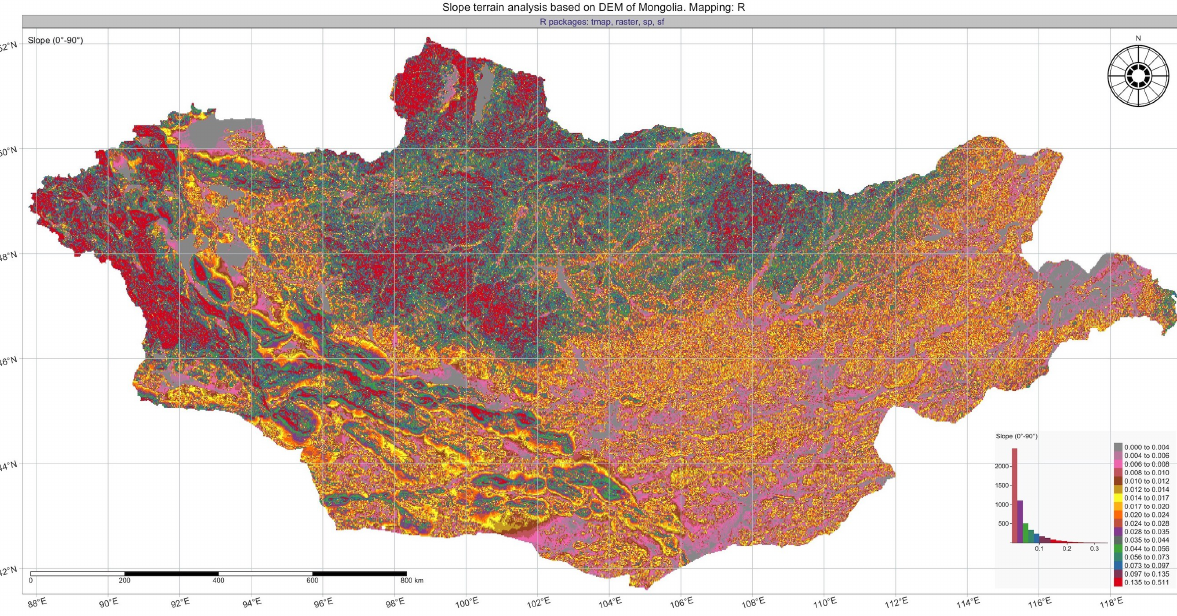
Fig. 7. Geomorphometric model of slope of Mongolia. Mapping: R. Source: